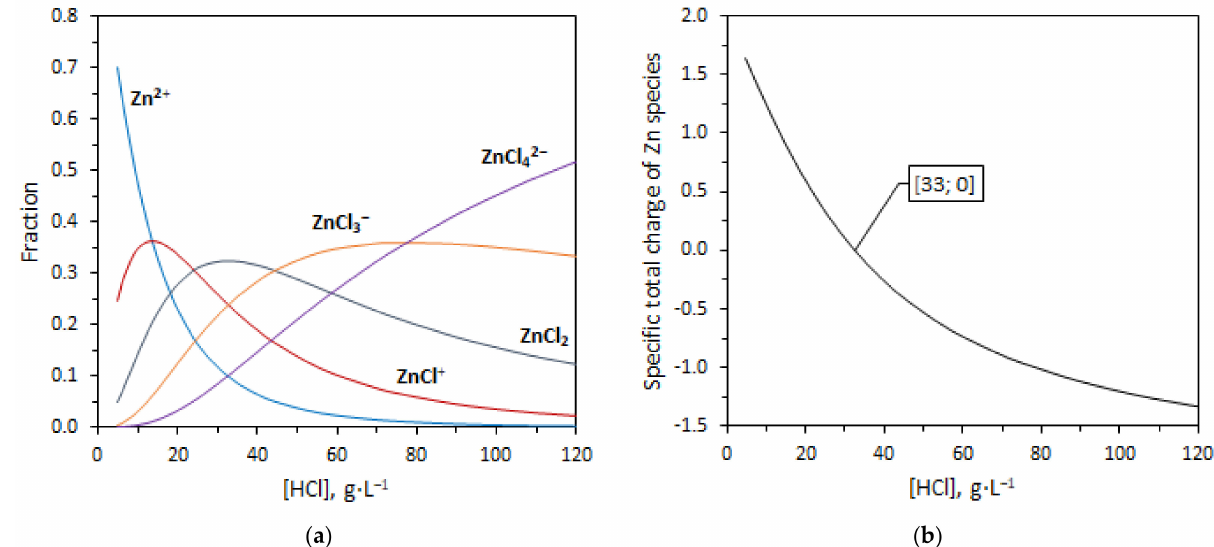
Figure 7. Distribution of Zn species in HCl solution ( a ) and ( b ) specific charge of Zn species as a function of the concentration of free HCl. Fraction values were obtained by numerically solving Equations